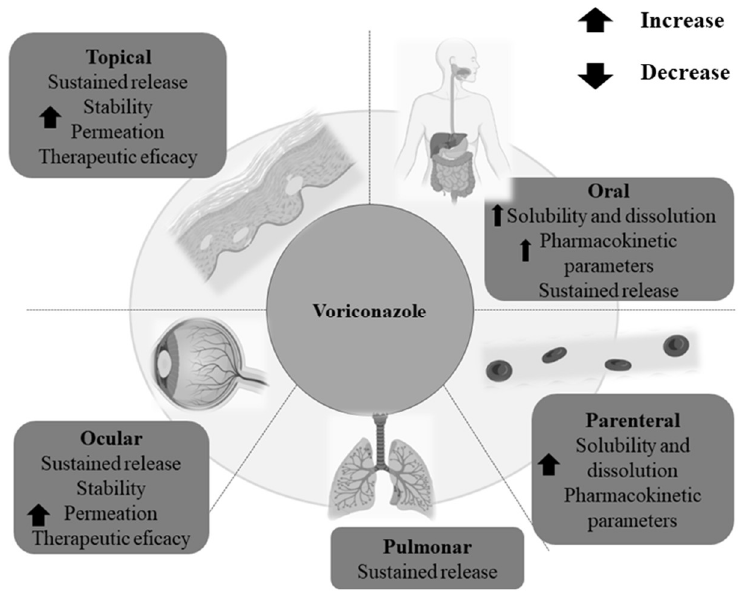
Figure 1. Possible routes for voriconazole delivery from nanoparticles.